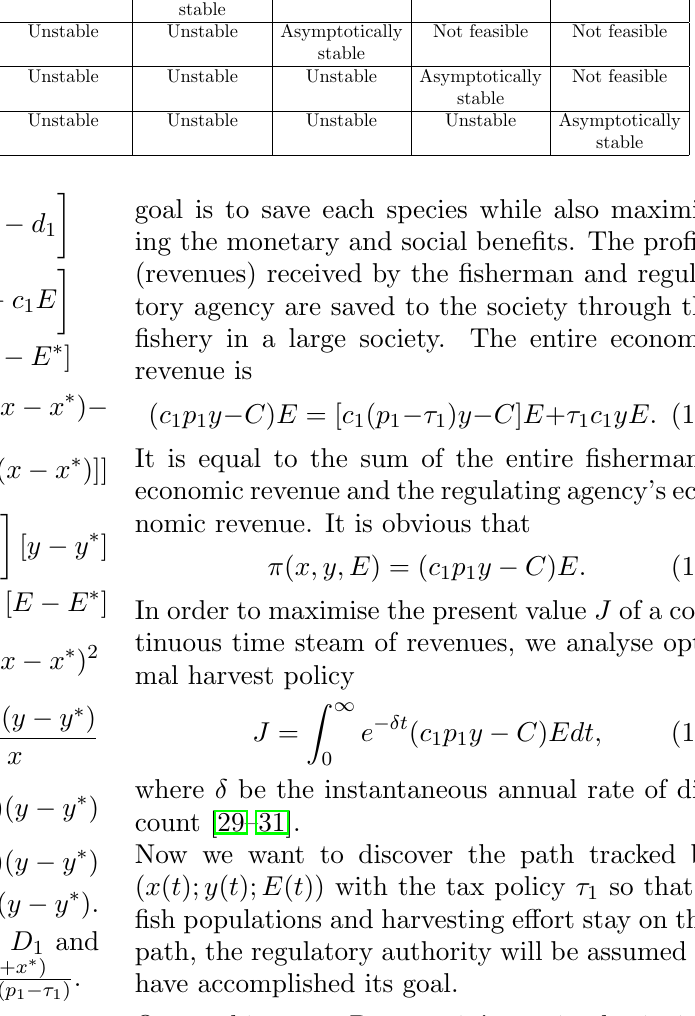
Table 1. The table depicting thresholds and stability of steady states. Thresholds S 0 (0 , 0 , 0) Unstable Asymptotically Not feasible Not feasible Not feasible Not feasible stable Unstable